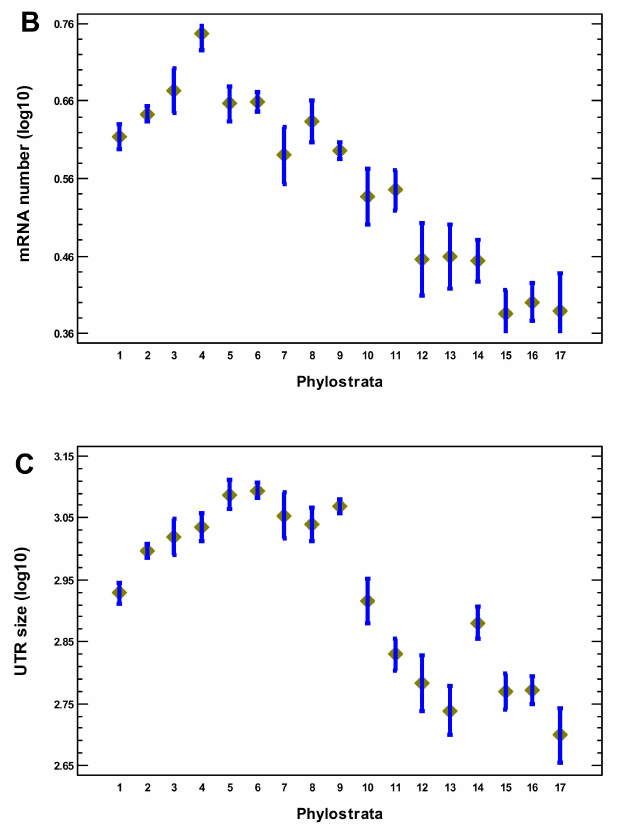
Figure 7. Phylostratic course of complexity-related gene properties. ( A ) Protein size. ( B ) Number of al- ternative splicing mRNA variants per gene. ( C ) Length of mRNA untranslated regions (UTR). Means with LSD intervals ( p < 0.05). (1—cellular organisms; 2—Eukaryota; 3—Opisthokonta; 4—Metazoa; 5— Eumetazoa; 6—Bilateria; 7—Chordata; 8—Vertebrata; 9—Euteleostomi; 10—Tetrapoda; 11—Amniota; 12—Mammalia; 13—Theria; 14—Eutheria; 15—Boreoeutheria; 16—Primates; 17—Hominidae.)